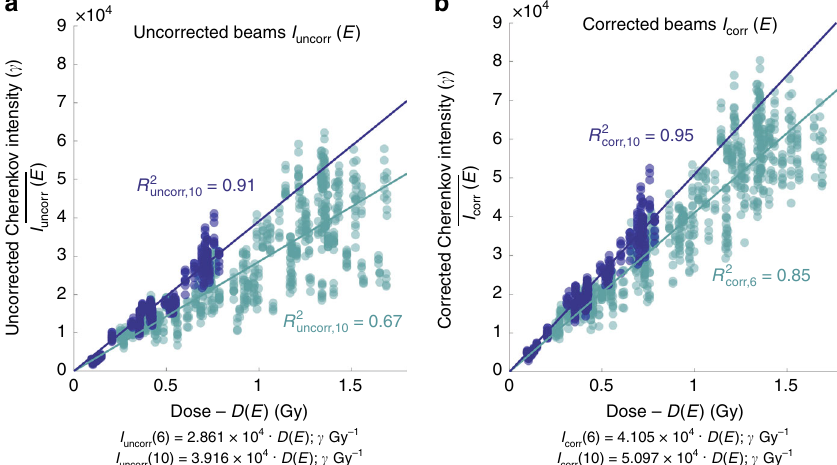
Fig. 6 The HU correction increases linearity between Cherenkov light and dose. The same number of regions of interest (ROI) per patient are sampled from each corrected and uncorrected Cherenkov image stacks and co-registered surface dose images to yield the relationships shown. The median Cherenkov intensities from uncorrected images ( a ) are plotted against corresponding ROIs from the predicted dose in the treatment plan. The median Cherenkov intensities from the corrected images are then plotted in the adjacent plot ( b ) for both 6 and 10 MV beams. The y -intercepts have been constrained to cross at the origin, which yields an uncorrected 6X beam regression R 2 uncorr,6 = 0.67 (light blue), which exhibits the largest spread of data. The HU-corrected 6X beam regression is improved by 0.18, to R 2 corr,6 of 0.85. The linear regression of the 10X beams are improved slightly by 0.04, from 0.91 to 0.95 (dark blue). The Pearson ’ s linear correlation coef fi cient increased from r uncorr,6 = 0.82 uncorrected to r corr,6 = 0.92 corrected in 6X beams, and from r uncorr,10 = 0.96 uncorrected to r corr,10 = 0.97 corrected for the 10X beams. All data are organized by beam energy, where light blue is representative of all 6 MV data and dark blue is representative of all 10 MV